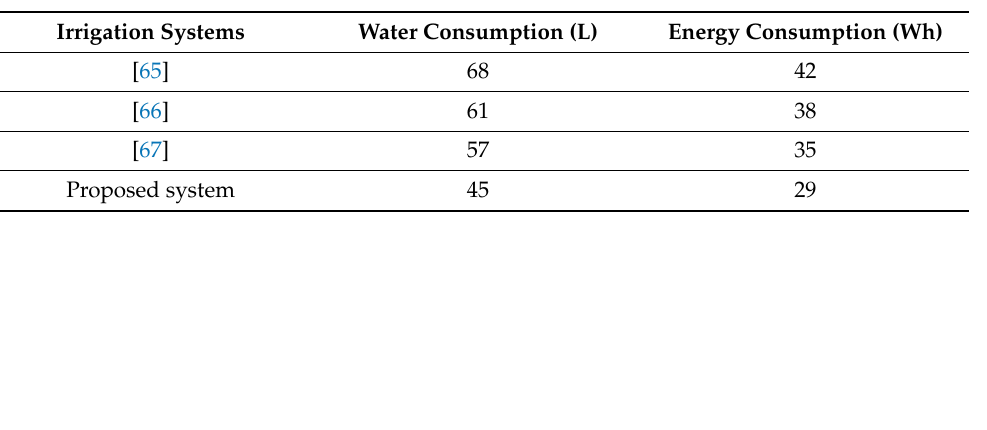
Table 8. Proposed system evaluation in aspects of energy and water